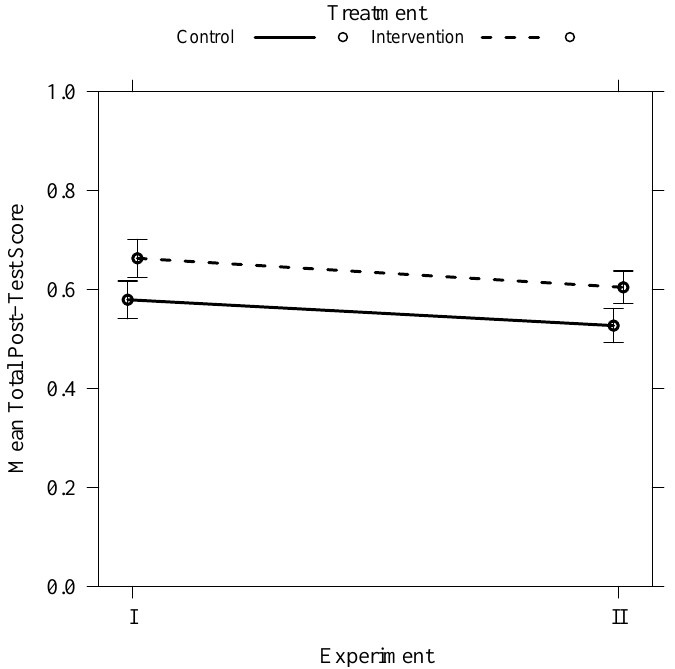
Figure 10. Mean post-test score as a function of experiment and treatment